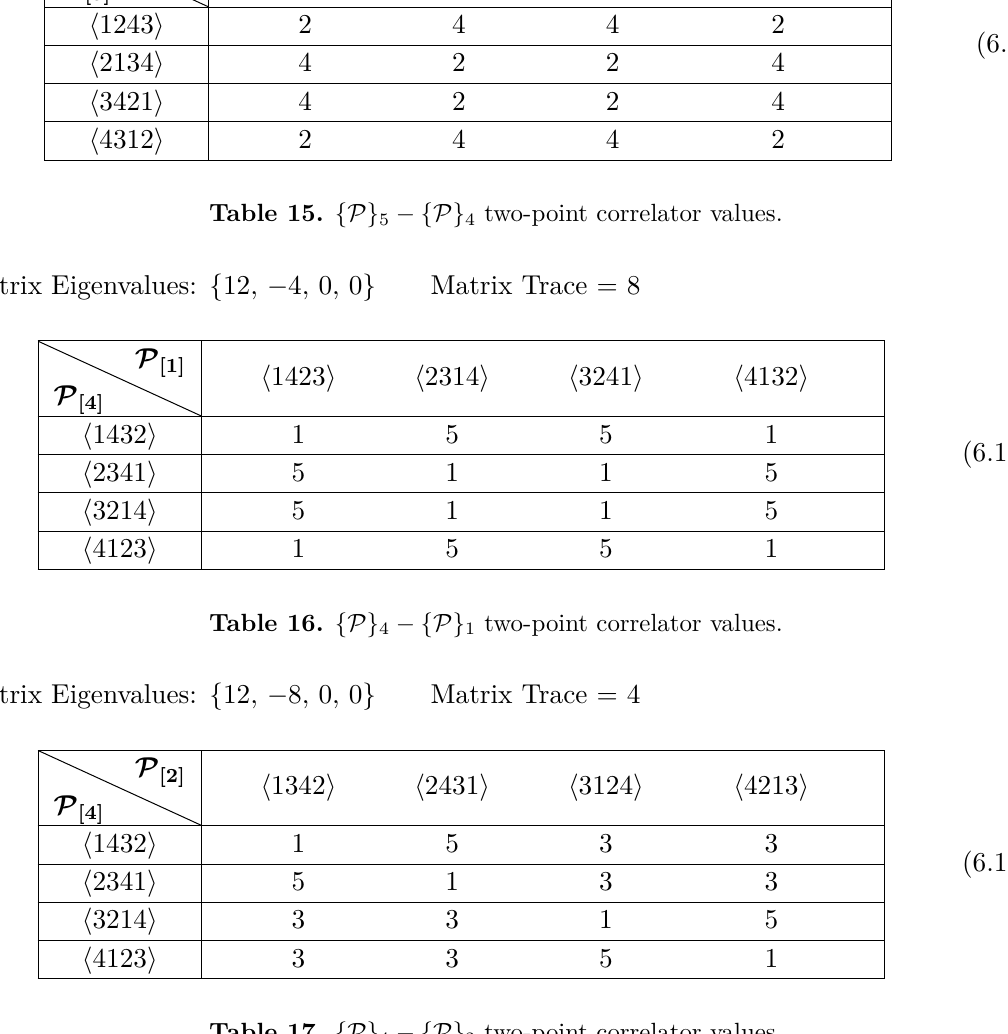
Table 17. {P} 4 − {P} 2 two-point correlator values.